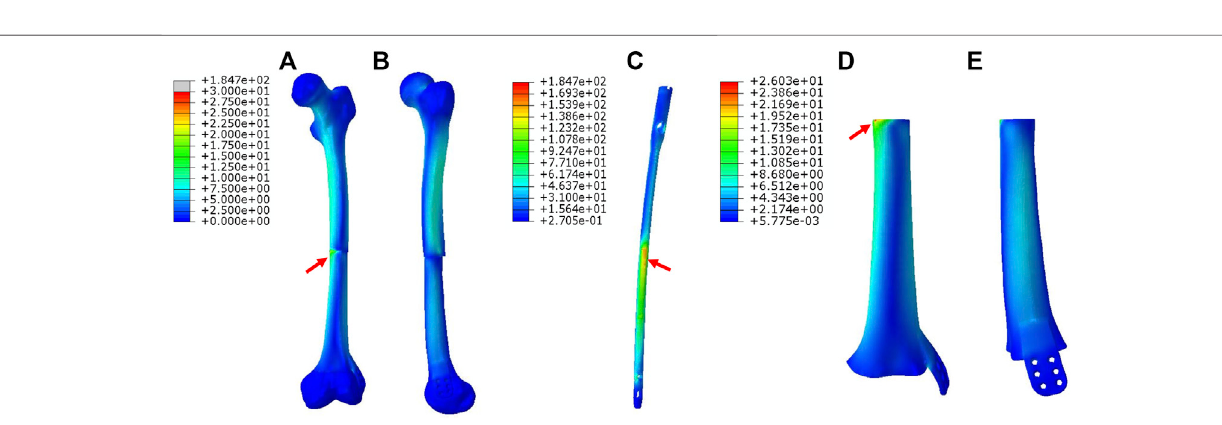
Frontiers in Bioengineering and Biotechnology |